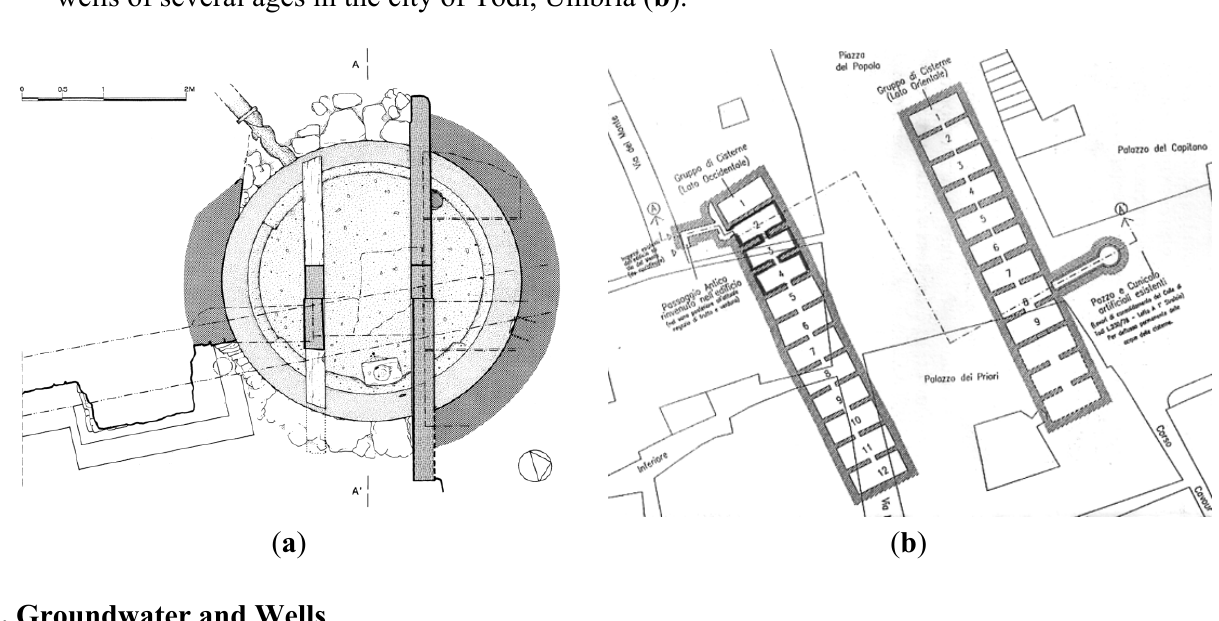
Figure 4. Plant of the cistern in Via Cesare Caporali , Perugia, central Italy ( a ) [27]; and Tunnels and galleries, more than 30 cisterns, Etruscan, Roman and Medieval and about 500 wells of several ages in the city of Todi, Umbria ( b